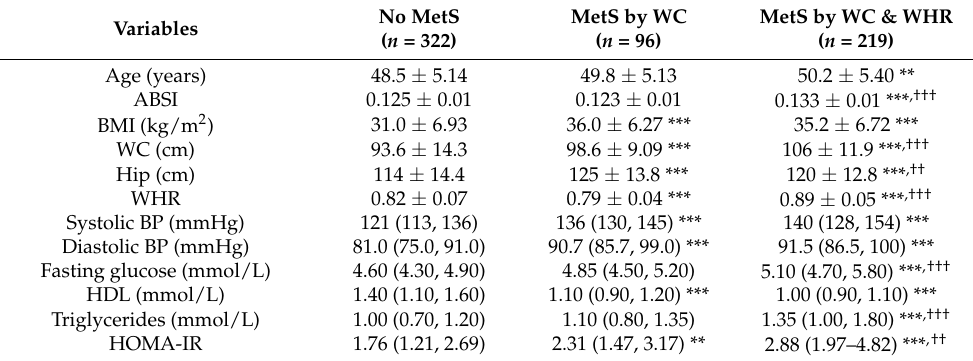
Table 5. Anthropometric and cardiometabolic data of subjects without metabolic syndrome, with metabolic syndrome diagnosed by waist only, and with metabolic syndrome diagnosed by both waist and waist-to-hip